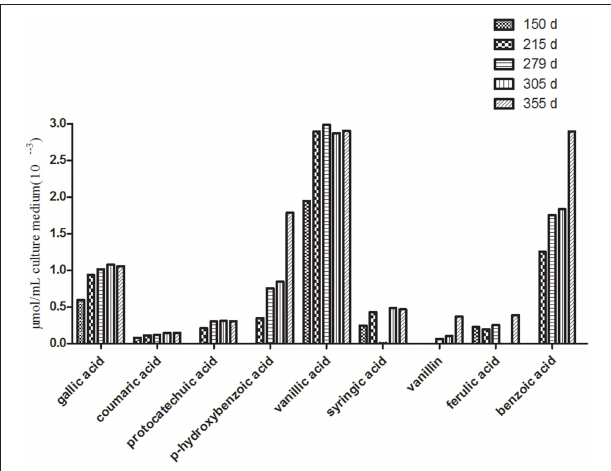
FIGURE 3 | Changes in the contents of the phenolic compounds in the tissue culture medium of R. pseudostellariae on different growth days.